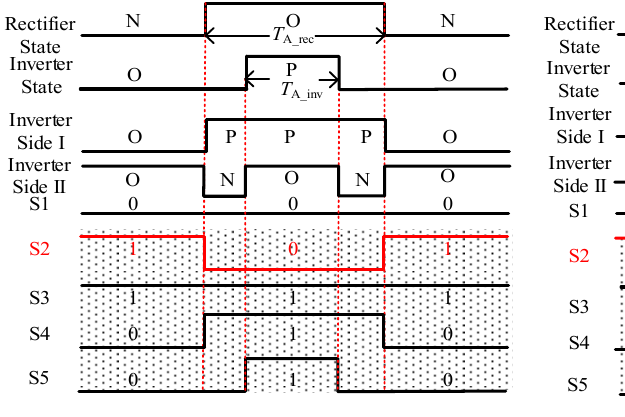
Figure 8. Converter state and switching commands. ( a ) ( u * A_rec − u z_rec ) < 0, ( u * A_inv − u z ) > 0, and